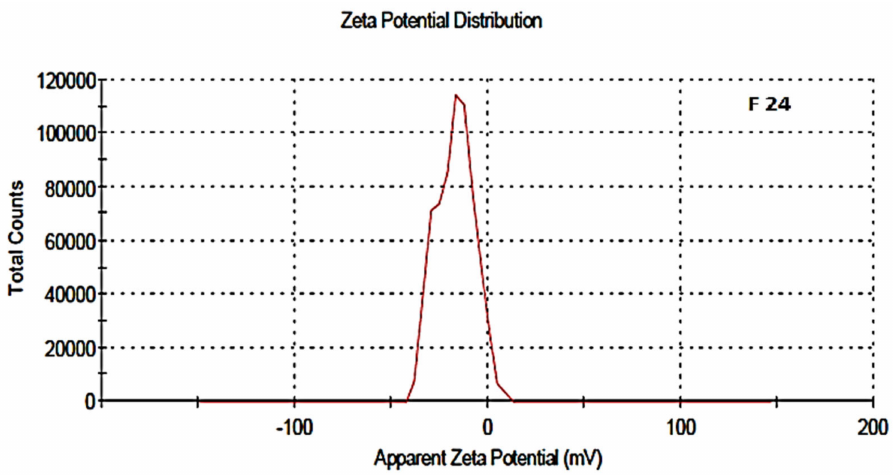
Figure 6. Zeta potential of blank NPs,